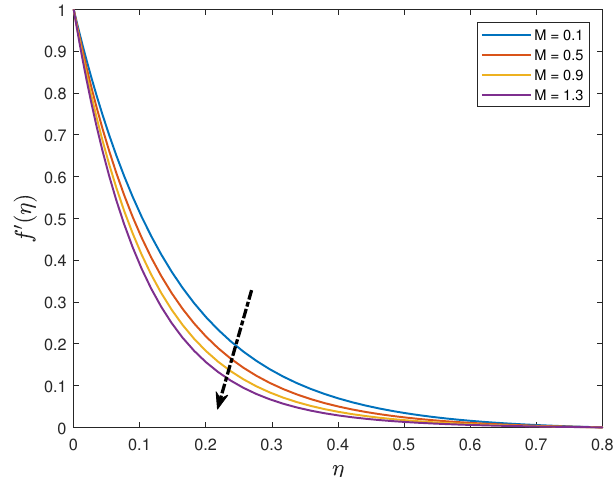
Figure 4. Influence of M on the nanofluid